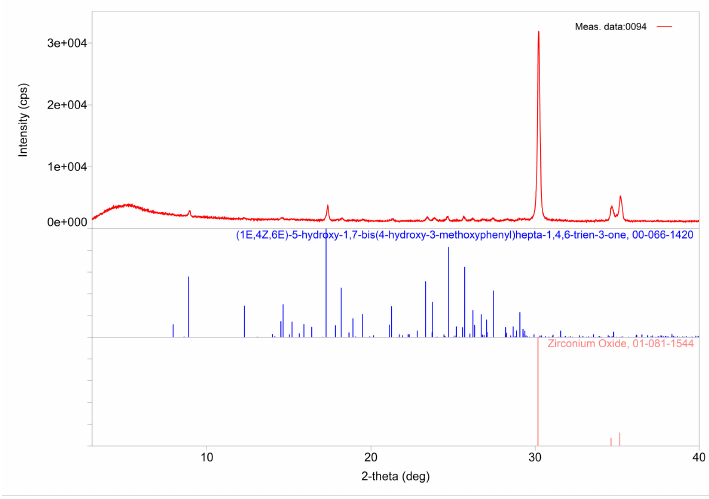
Figure S1: XRPD pattern for F_P80. Reference XRPD patterns for curcumin (card number 00-066-1420; ICDD (PDF-2 Release 2016 RDB)) and zirconium oxide (card number 01-081-1544; ICDD (PDF-2 Release 2016 RDB)) in blue and red are below the experimental pattern. Specimen contains 71(1)% of curcumin and 29(1)% of zirconium oxide.